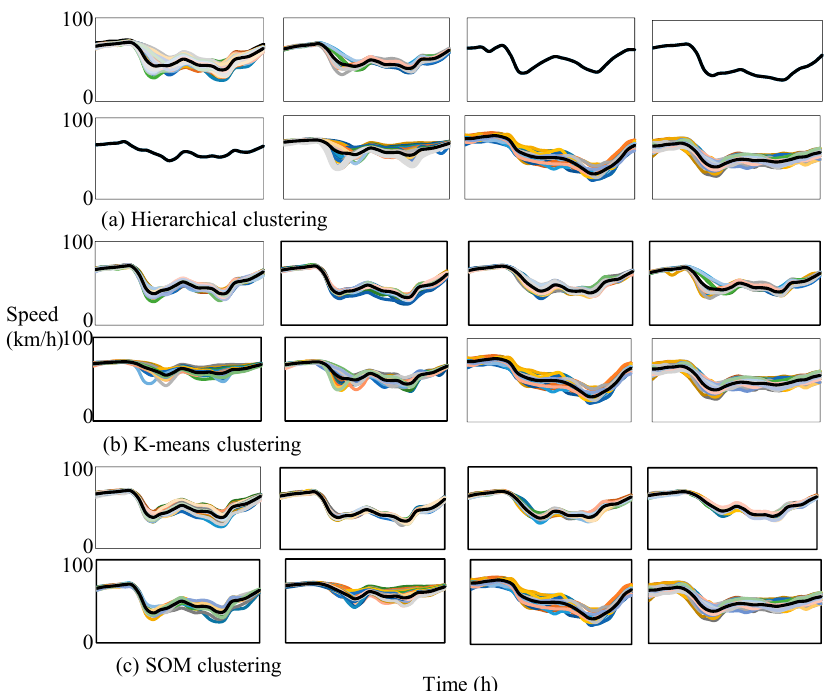
Figure 4. The categories of DI based on different algorithms (curves with different colors mean different days).